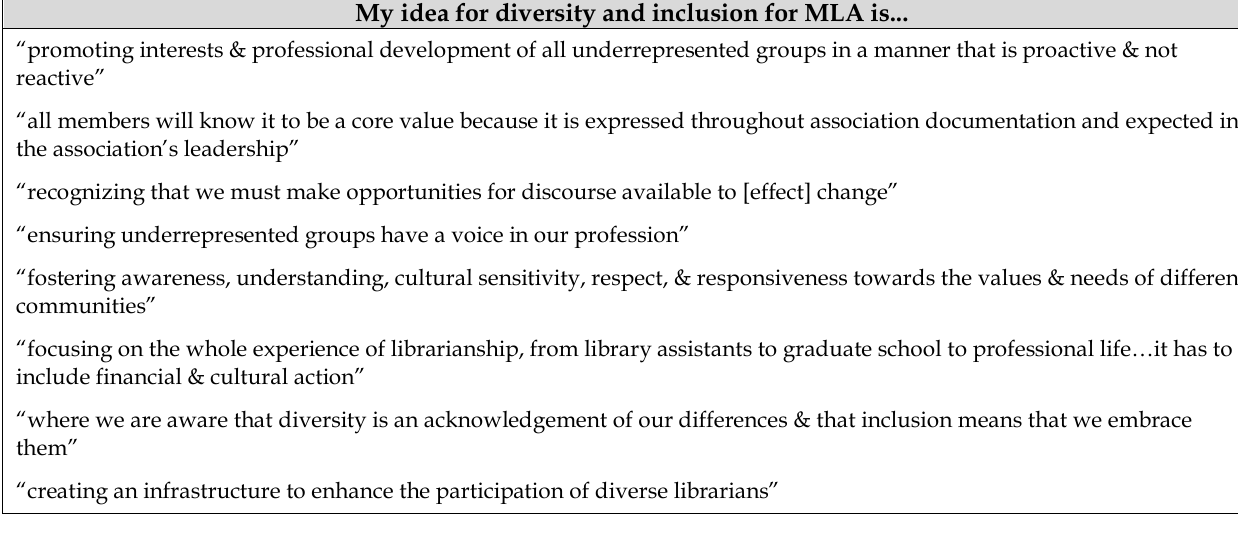
Table 1 DITF members’ responses to the discussion prompt “My idea for diversity and inclusion for MLA is…” My idea for diversity and inclusion for MLA